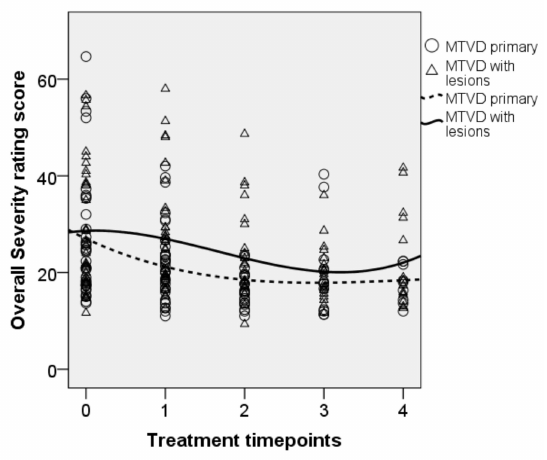
Figure 2. Longitudinal plot of data for the overall severity ratings. Trend line is shown for each subgroup. 0 = baseline, 1 = OPT, 2 = SVQ, 3 = SVQ variant, and 4 =